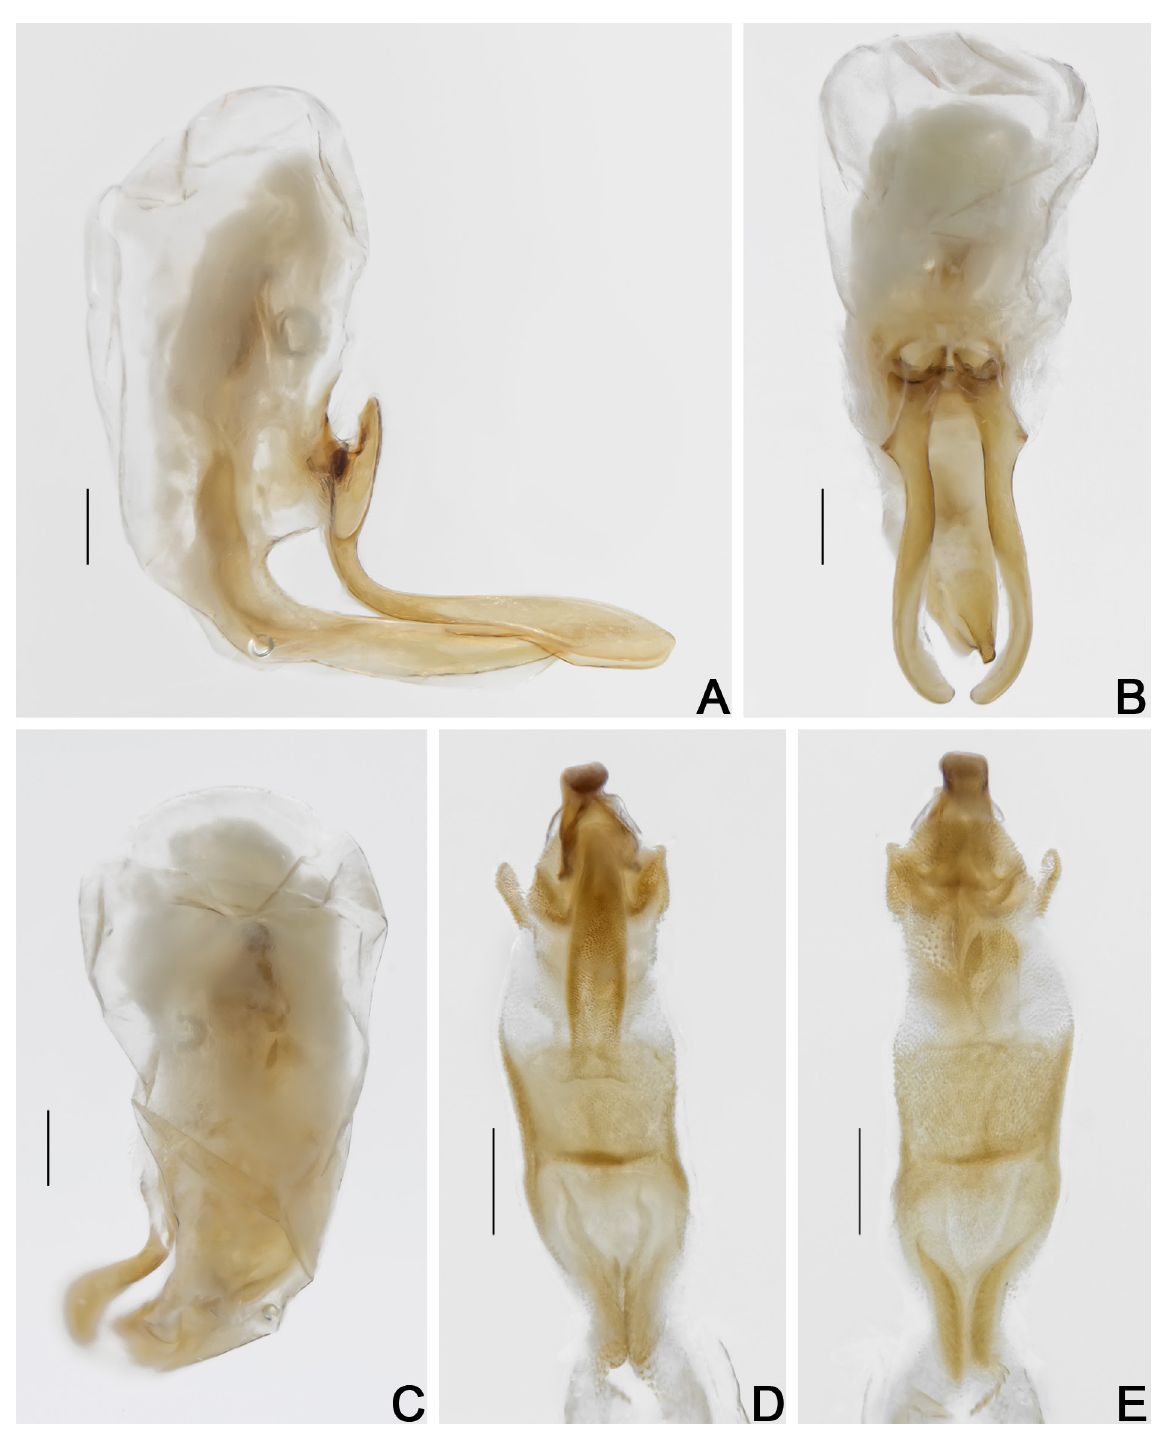
Fig. 62. Cyparium oberthueri Pic, 1956, ♂ (CELC). A–C . Aedeagus. A . Lateral view. B . Frontal view. C . Dorsal view. D–E . Internal sac. D . Frontal view. E . Dorsal view. Specimen collected at Mata da Biologia, Viçosa (MG, Brazil). Scale bars = 0.2